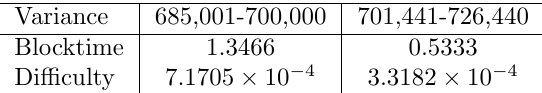
Table 2: Variance in 24 hour (1440 blocks) average blocktime and difficulty before and after tail